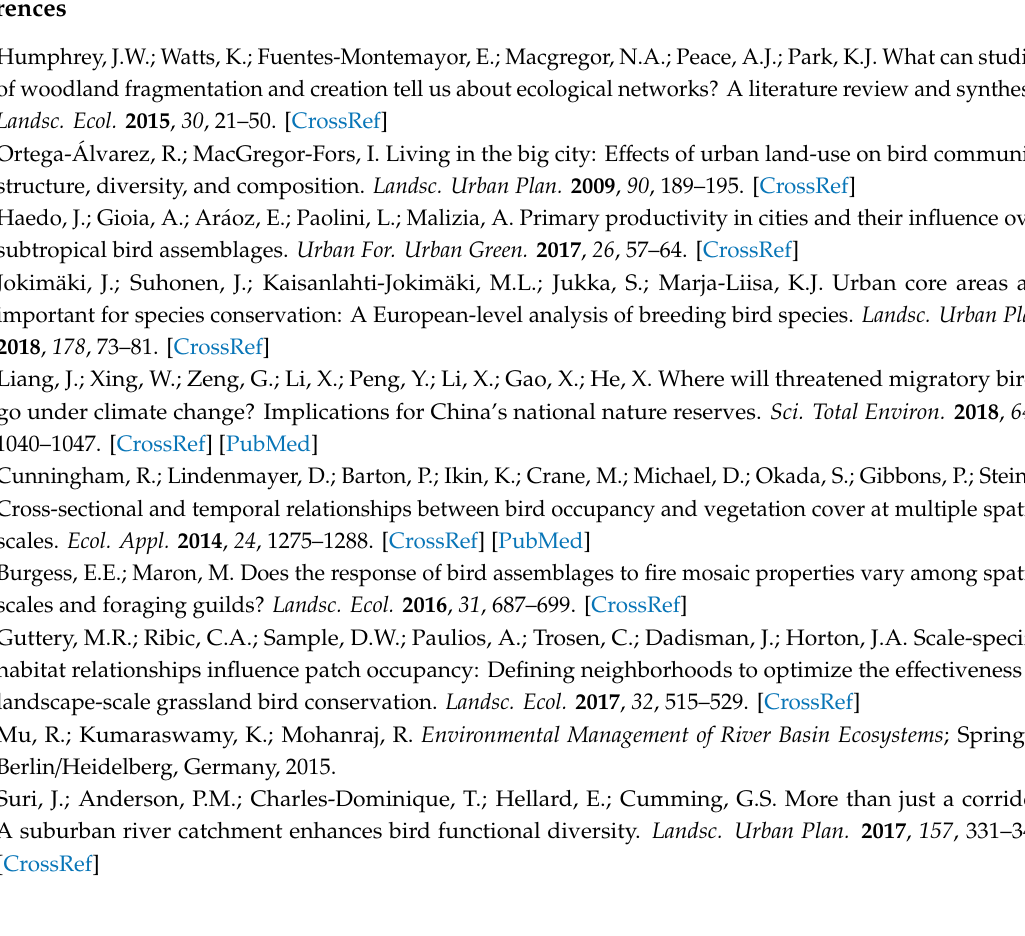
Table S1: Species list, Table S2: Dispersal distances (DD) of species, Table S3: Correlation between landscape connectivity and biodiversity in di ff erent